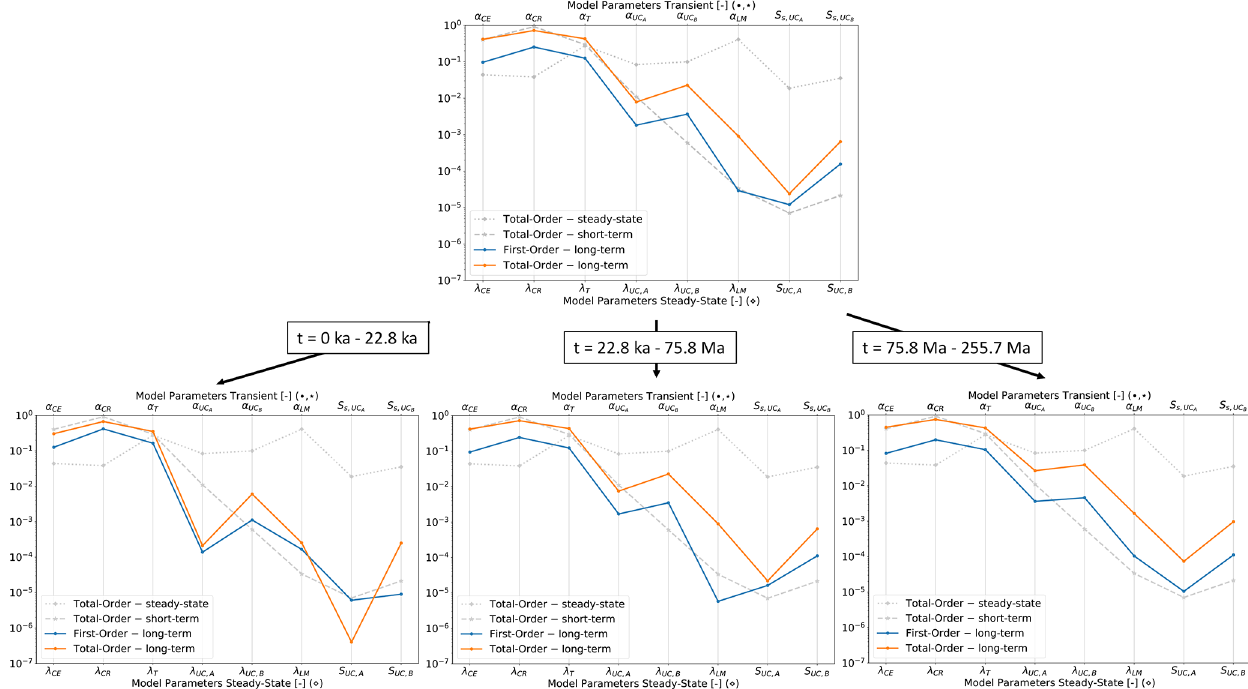
Figure 12. Global sensitivity indices for the analysis considering a simulation time of 255.7Myr. The first-order indices are denoted in blue and the total-order indices in orange. Additionally, the total-order indices of the short-term (dashed grey line) and steady-state analyses (dotted grey line) are plotted. For the acronyms, please refer to Table A1 (modified after Degen et al.,